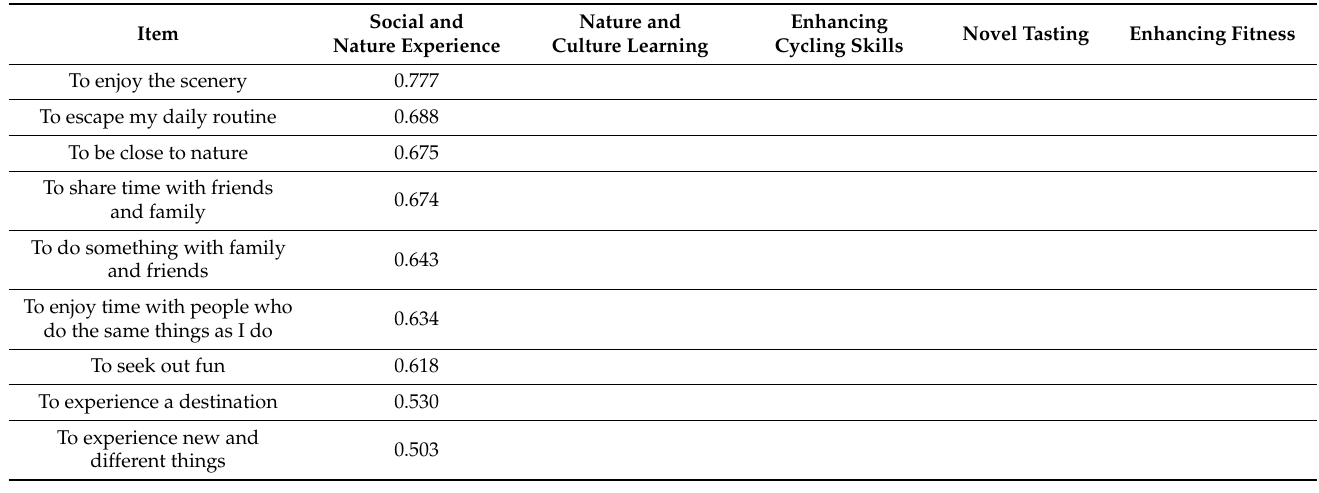
Table 2. Factor analysis of motivation.